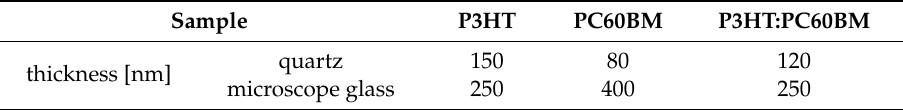
Table 1. Sample thicknesses determined by spectroscopic